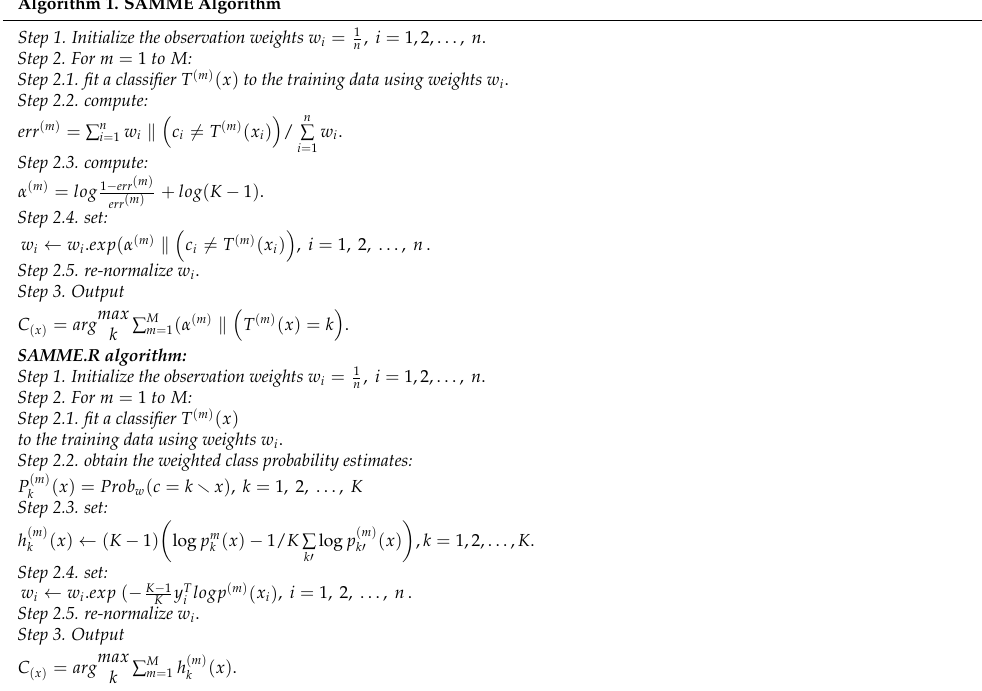
Algorithm 1. SAMME